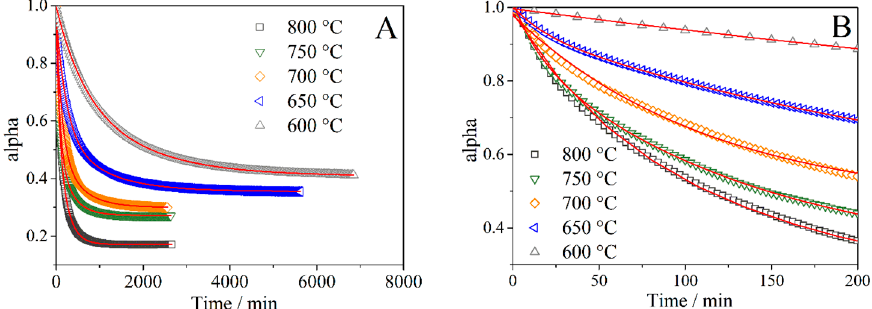
Figure 2. The dependence of the 18 O oxygen isotope fraction in the gas phase (alpha) on the time at P O2 = 10 − 2 atm. ( A ) and fragment of the dependence of the initial section ( B ).